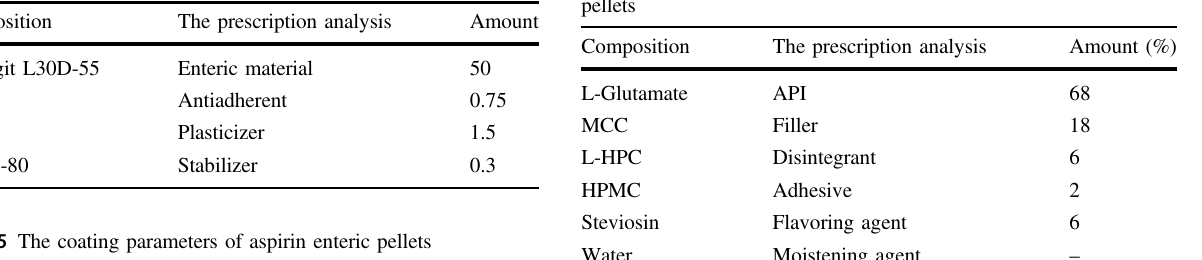
Table 7 The composition of prescription of L-glutamate drug-loaded